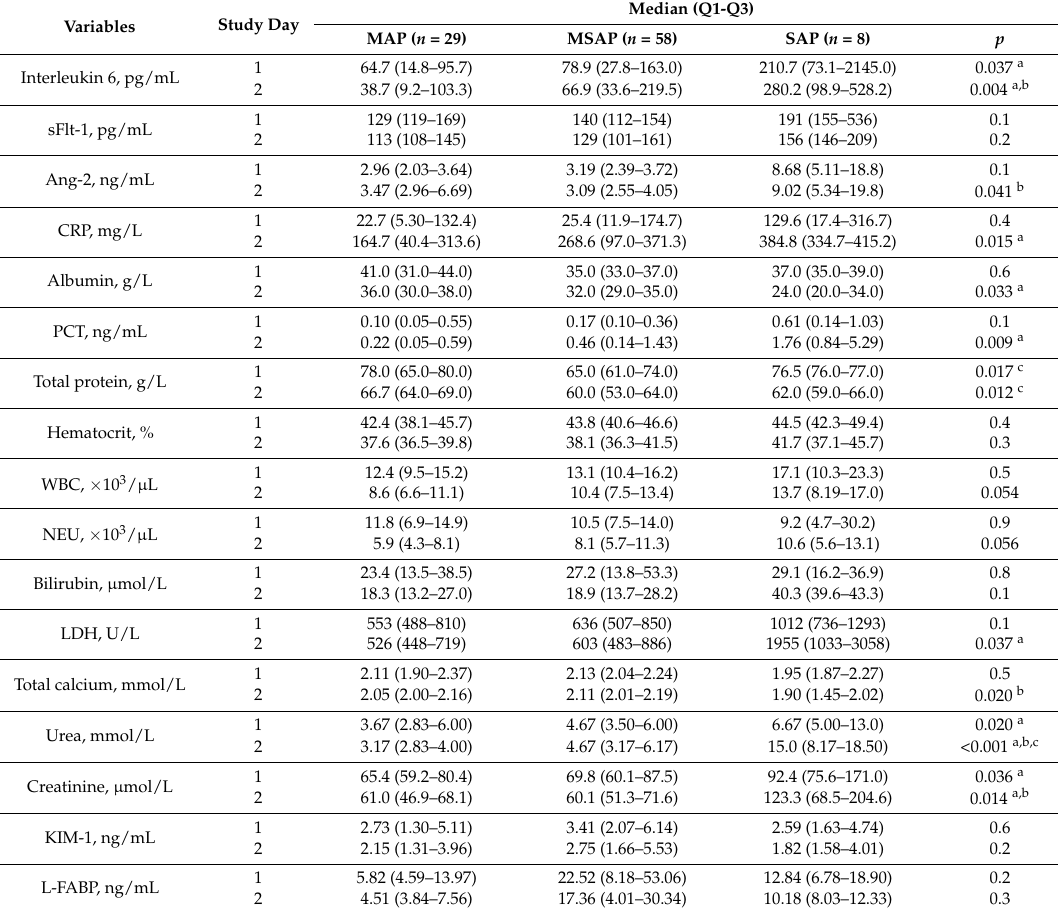
Table 2. The results of laboratory tests on admission (day 1) and on day 2 of hospital stay according to severity of